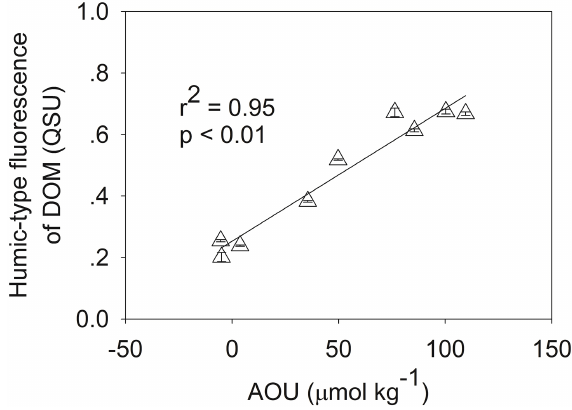
Fig. 6. Relationships between humic-type fluorescent dissolved or- ganic matter (FDOM) and apparent oxygen utilization (AOU) in the euphotic zone of CE1. Error bars indicate standard